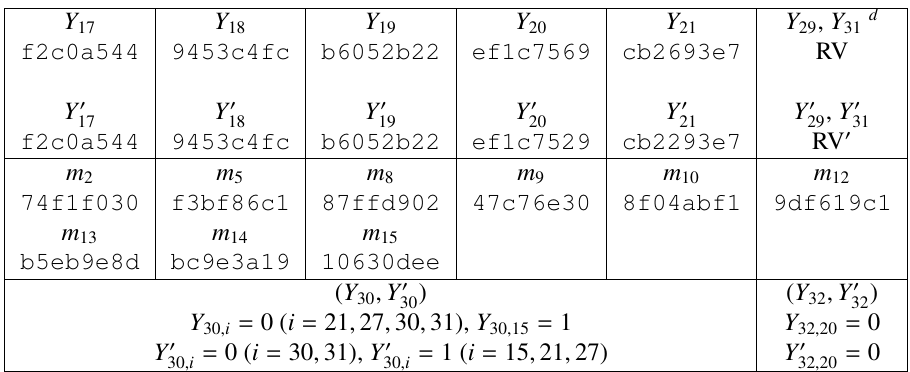
Table 6: An Example of the 17-32 Steps Di ff erential Path in the Right